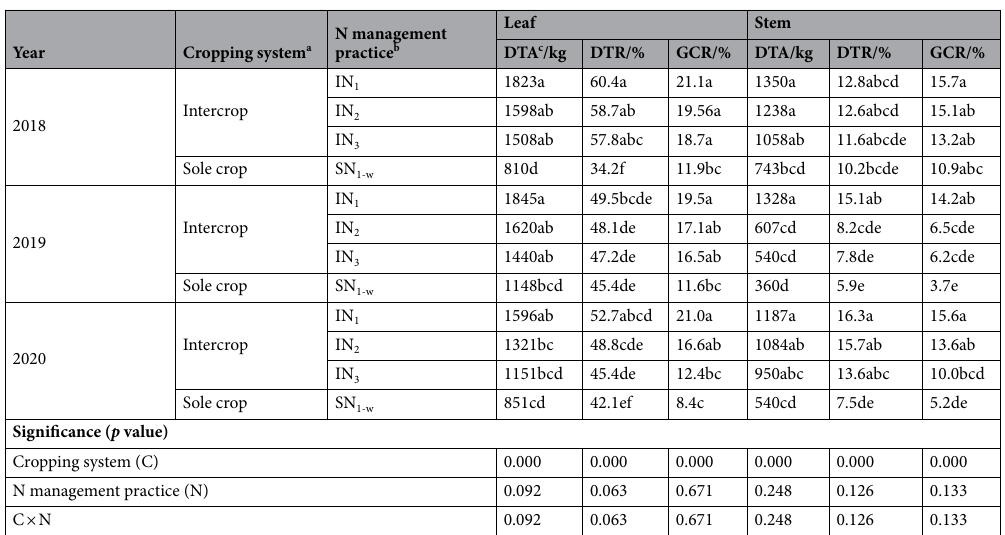
Table 1. Dry matter translocation and contribution rate to grain yield of leaf and stem in wheat in intercropping and sole cropping systems under different N management. Means with the same lowercase letters in the same column are significantly different at P ≤ 0.05. a Intercrop and sole crop means the intercropped wheat and sole wheat. b For intercropping system, N 1 , N 2 , and N 3 represent N-fertilizer applied at 51, 72, and 93 kg N ha −1 as first top-dressing plus 63, 42, and 21 kg N ha −1 at third top-dressing, respectively. For sole cropping, N 1 represents N-fertilizer applied at 108 kg N ha −1 as base fertilizer plus 72 kg N ha −1 at top-dressing. c DTA is transportation amount of dry matter in vegetative organ (kg); DTR is transfer rate of dry matter in vegetative organ (%); GCR is contribution rate of vegetative organs to grain (%).